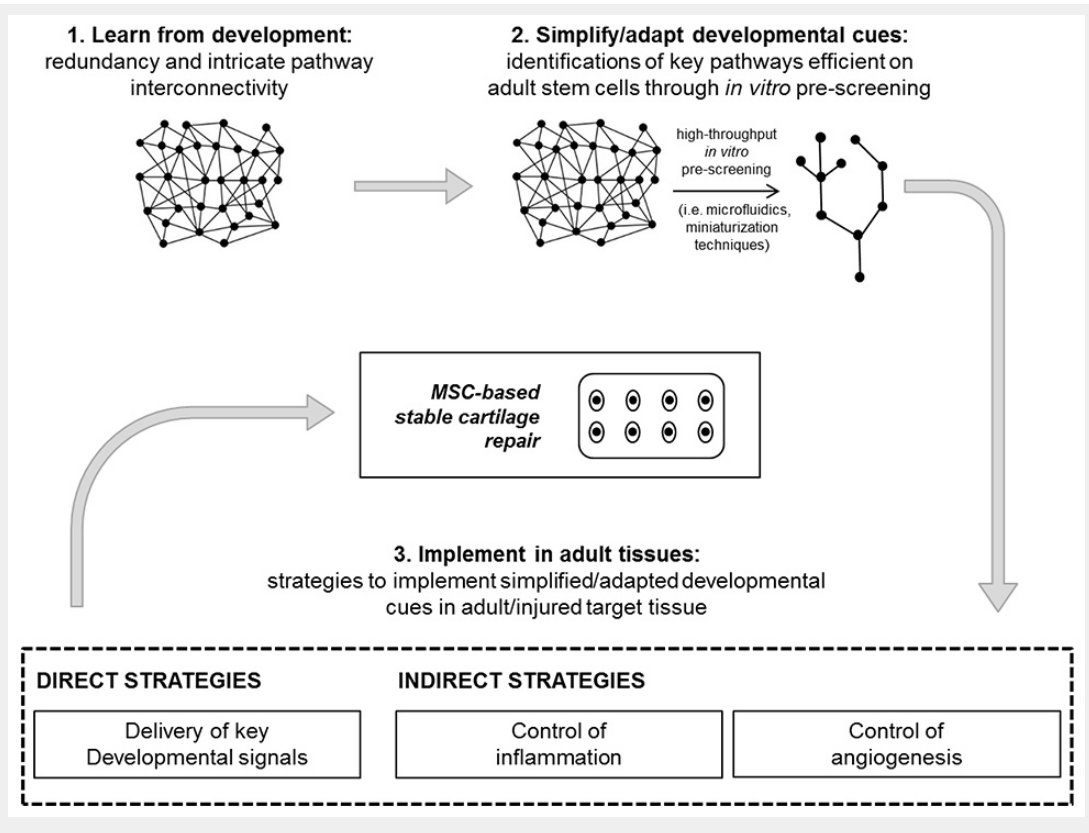
Developmental re-engineering concept: learn, simplify/adapt, implement. After the understanding of pathways involved in the embryonic development of the targeted tissue to repair (1), a simplification/adaptation step is required to extrapolate from the in-vivo complexity the key signals that are effective in adult stem cells models. This step (2) could be accelerated by using recently introduced high-throughput in-vitro screening tools. The most effective developmentally inspired protocol defined in vitro for the acquisition of functional cartilage is then implemented in the adult/injured target tissue. For this aim, different strategies, either direct or indirect, can be identified